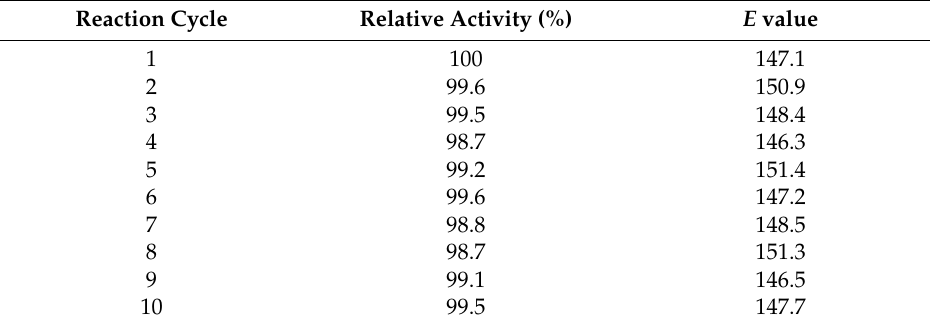
Table 1. Reusability of the nanobioreactor under